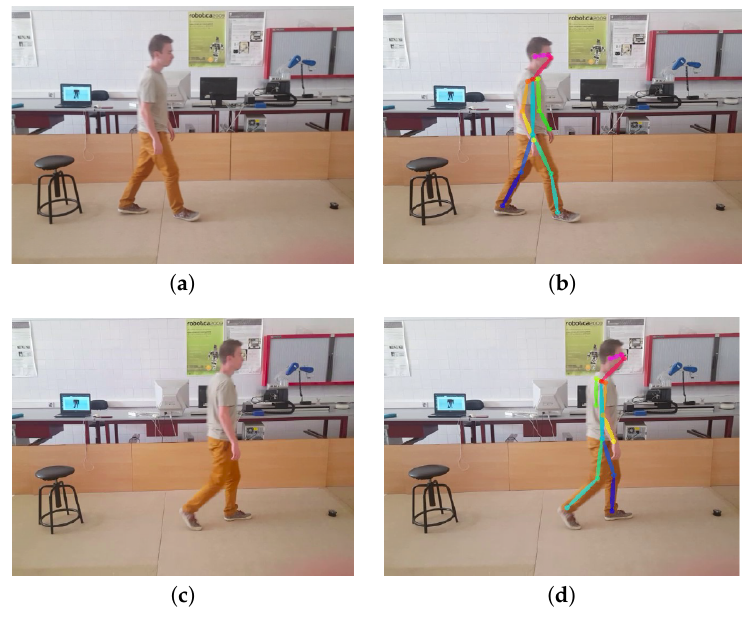
Figure 7. Examples of acquired frames of the exercise performed: ( a ) frame 39; ( b ) frame 39 with body model; ( c ) frame 65; ( d ) frame 65 with body